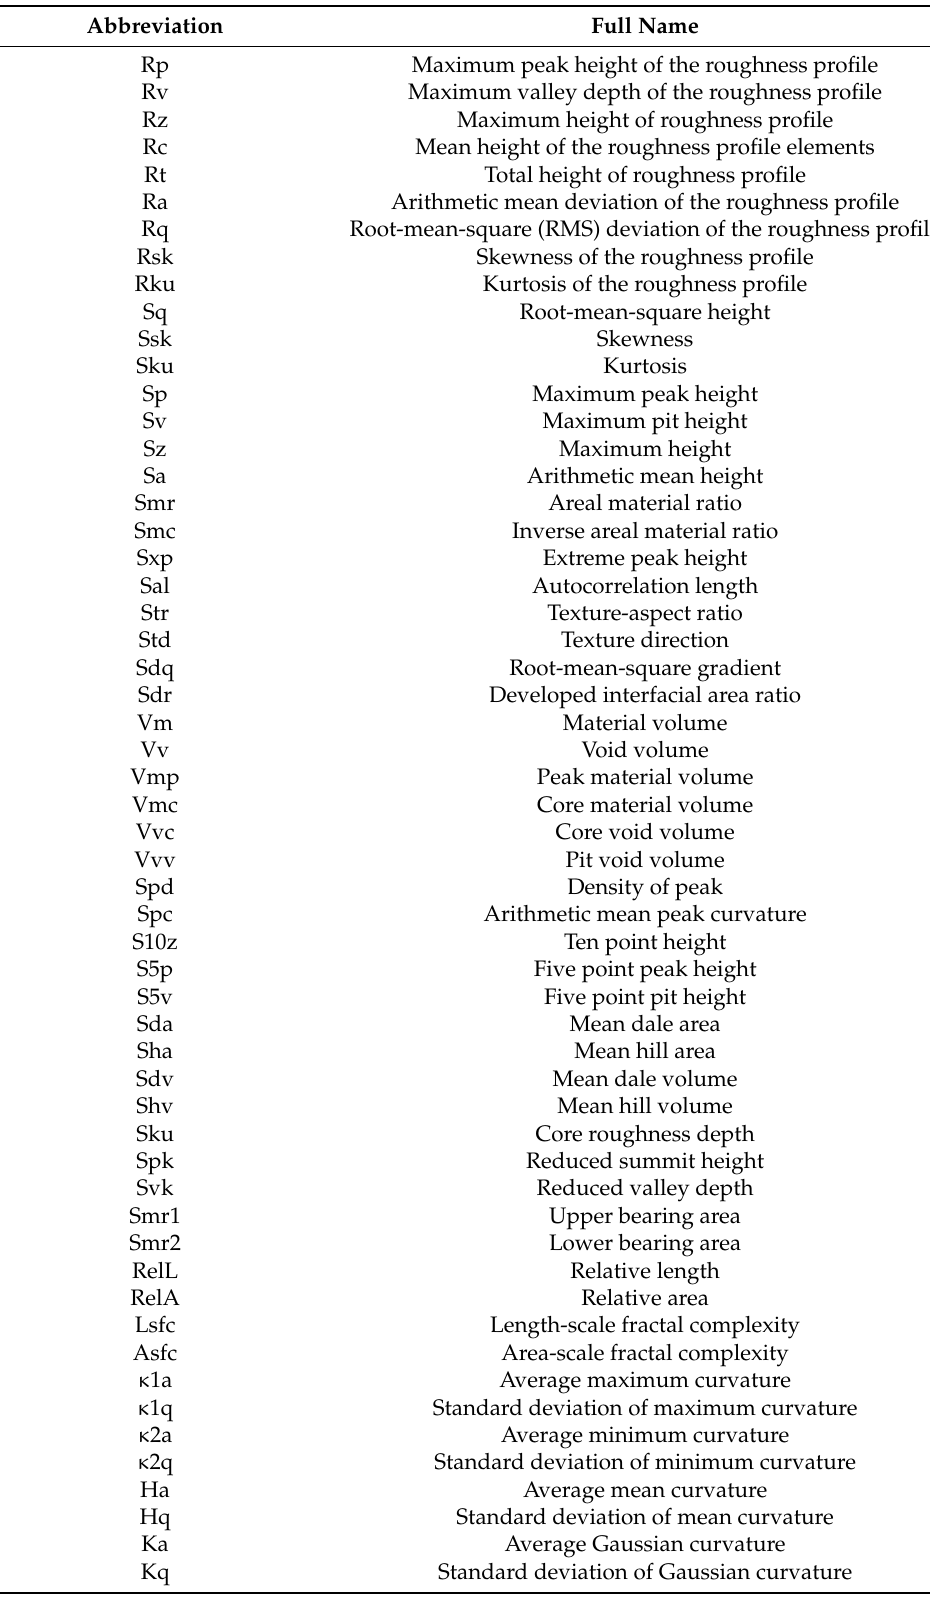
Table A1. Abbreviations of standard surface characterization parameters and their full